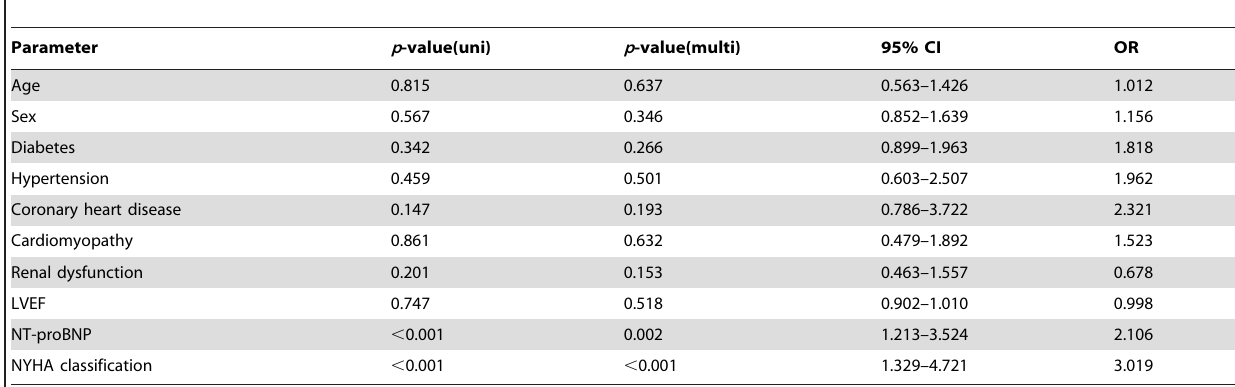
Table 5. The multivariate analysis of urinary ORM1/Cr level and clinical parameters.